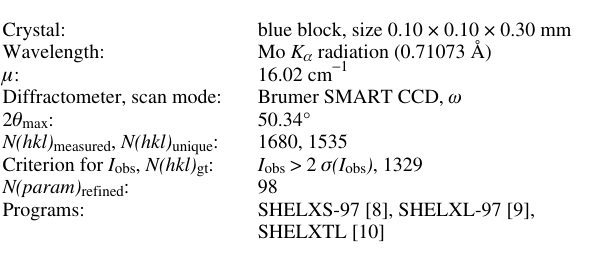
Table 1. Data collection and handling.